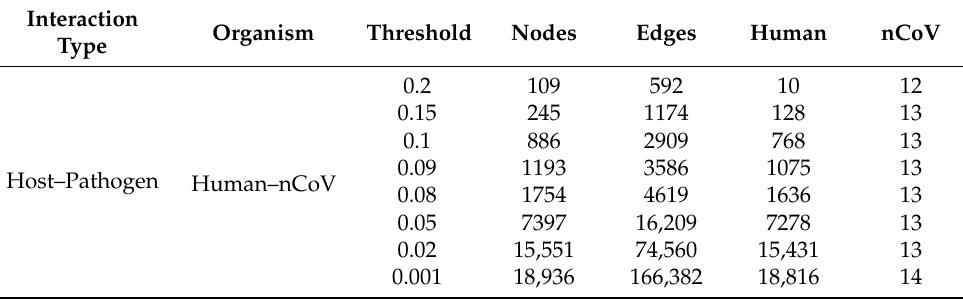
Table 4. Details of Human–nCov Interactions at different threshold